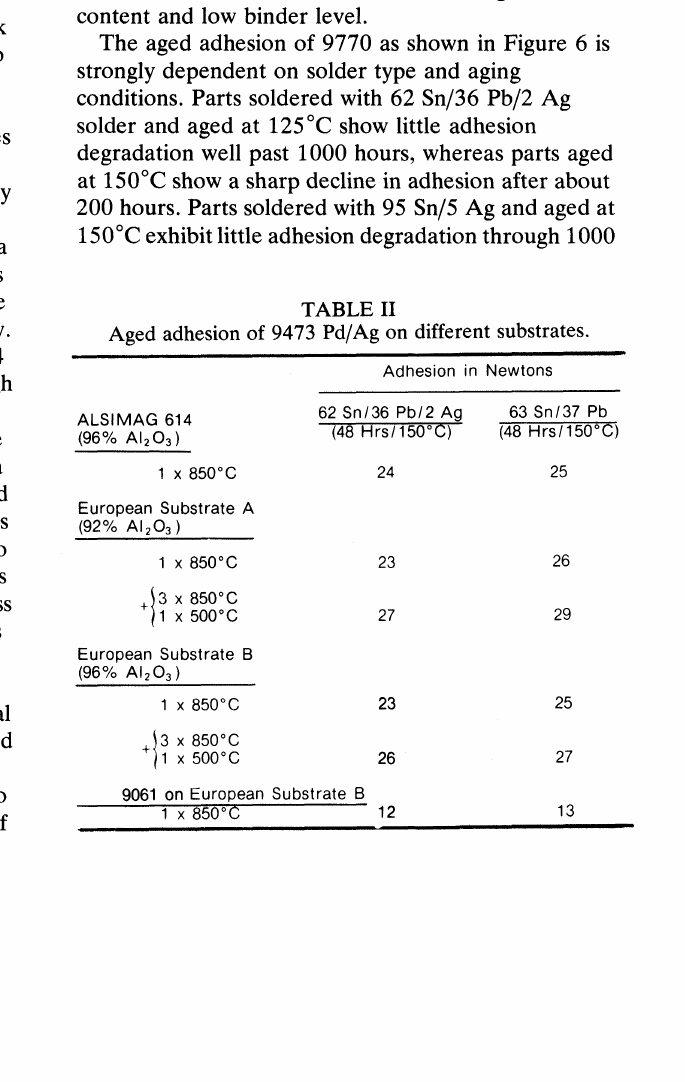
FIGURE 4 Aged adhesion vs. aging time and temperature for 9770 Pt/Ag. into the conductor film, may not be the sole cause of adhesion degradation of 8151.